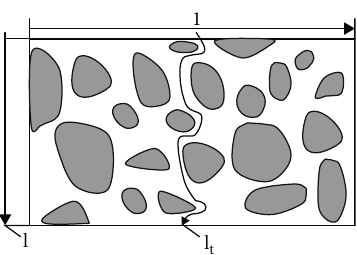
Figure 5: Schematic diagram of pore channel of unit